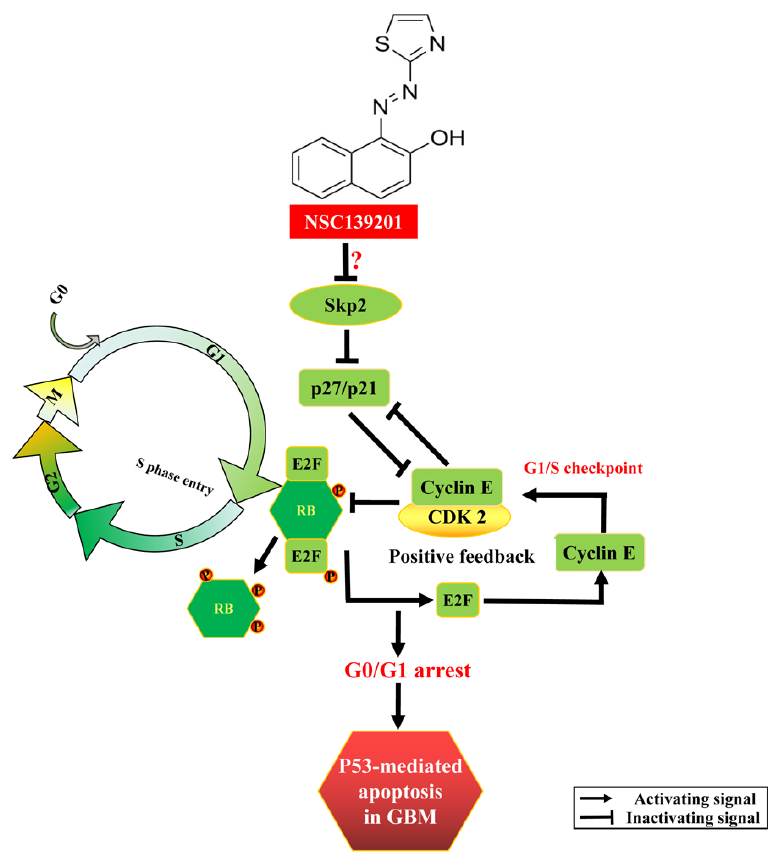
Figure 6. A schematic of the working mechanism of NSC139021 in glioblastoma. NSC139021 induces cell cycle arrest via the Skp2-p27/p21-Cyclin E/CDK2-pRb axis and triggers apoptosis via activating the p53 signaling. NSC139021 decreases the protein level of Skp2, which leads to the accumulation of p27 and p21. Subsequently, p27/p21 enhances the inhibition of CDK2, reduces the combination of CDK2 and Cyclin E, and decreases the dissociation of Rb and E2F. As the G1/S checkpoint, hy- perphosphorylated Rb dissociates E2F that downregulates the expression of Cyclin E and forms positive feedback in the G1/S transition, and eventually activates the p53 pathway to induce cell